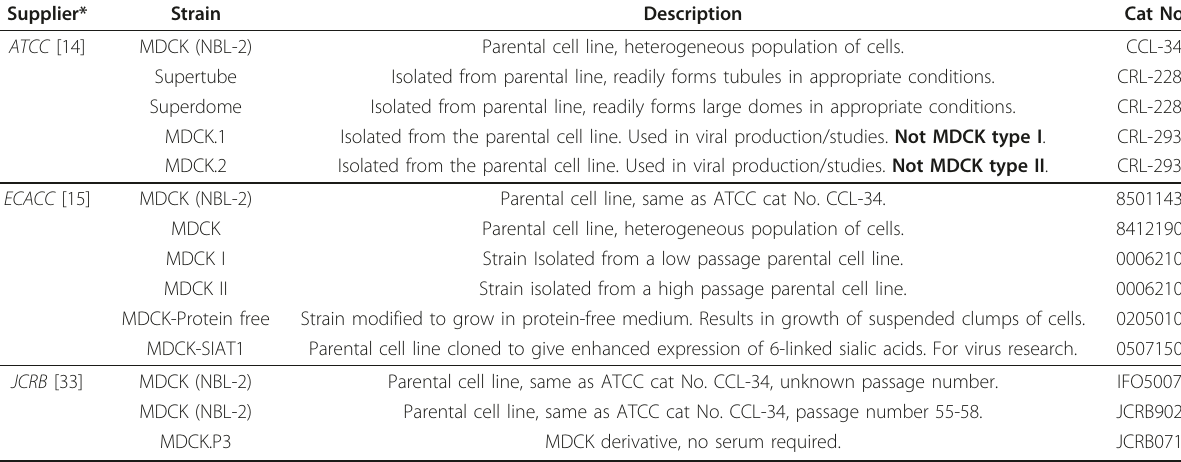
Table 1 MDCK cell strains sold by three commonly used tissue culture vendors *